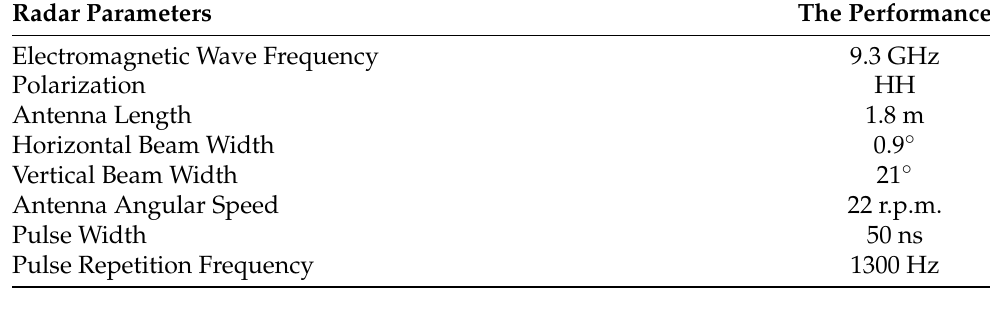
Table 2. The main configuration parameters of X-band marine radar.